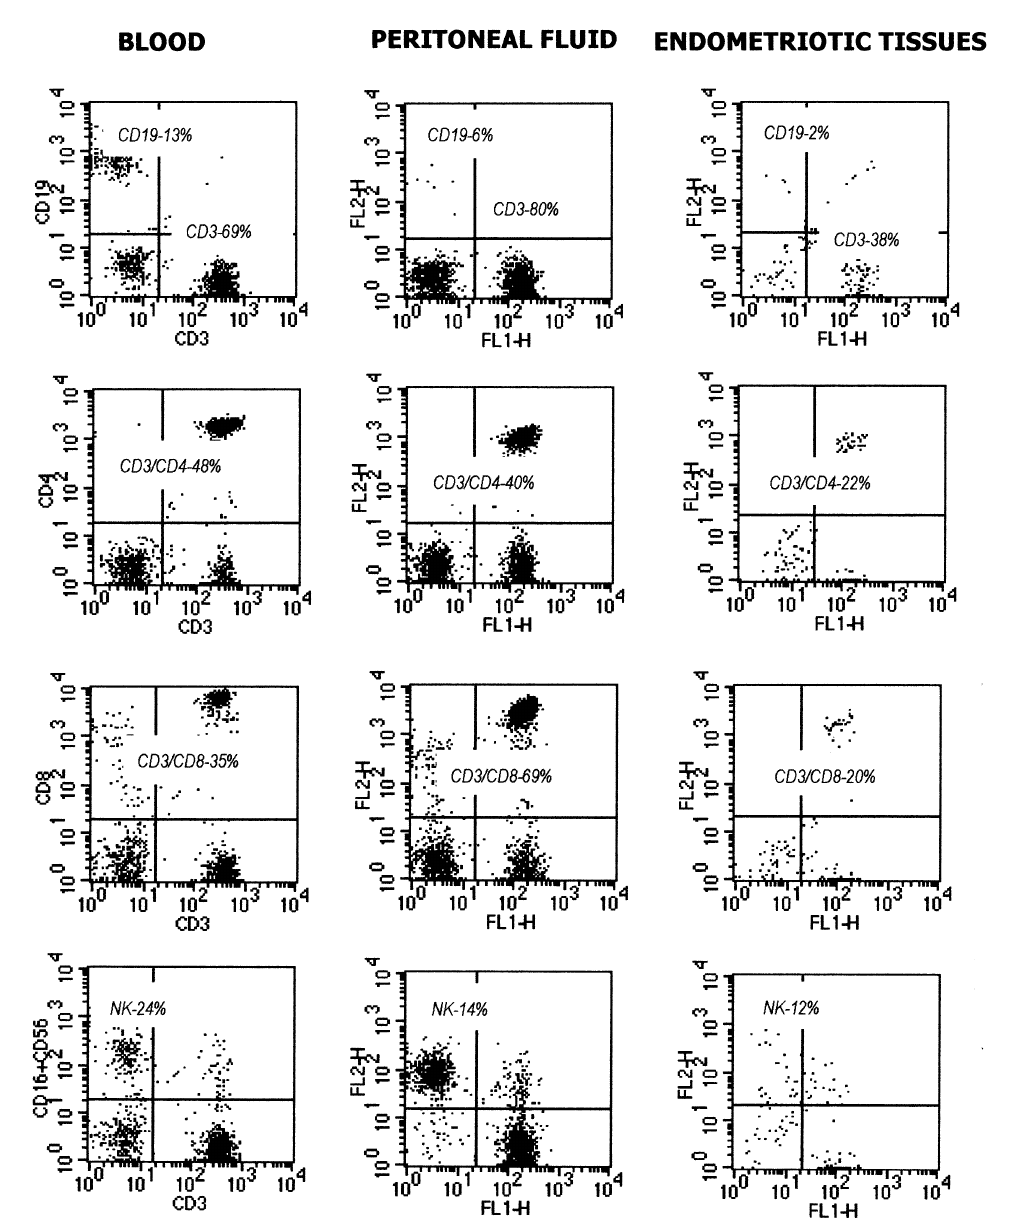
FIG. 2. Distribution of CD19, CD3, CD4, CD8 and NK cells among peripheral blood, peritoneal fluid and endometric tissue of women with endometriosis. A representative example of one patient investigation is presented. The diminished number of NK cells in peritoneal fluid and endometric tissue was noted.